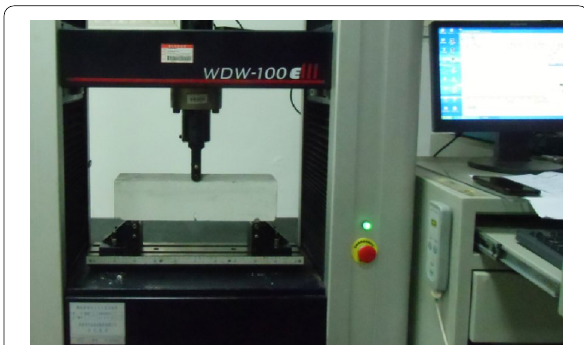
Fig. 4 Experimental setup of three-point bending